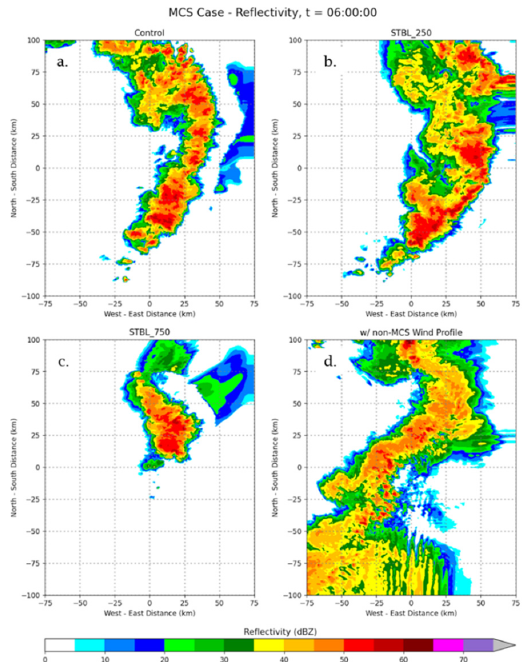
Figure 17. Simulated lowest model reflectivity for the 13 June 2016 MCS event in ( a ) the CTRL, ( b ) SBL250, ( c ) SBL750, and ( d ) WINDR experiments.